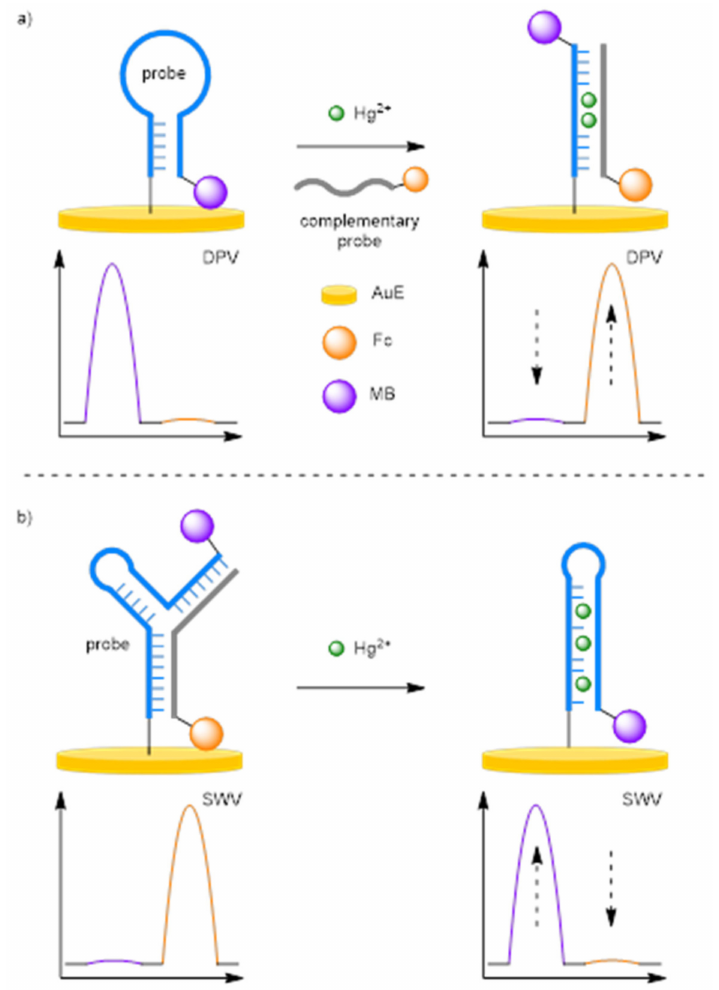
Figure 3. ( a ) The detection of Hg 2+ using DNA-templated metallisation of a thymine-rich hairpin DNA probe. ( b ) The detection of Hg 2+ using DNA-templated metallisation of a Y-shaped